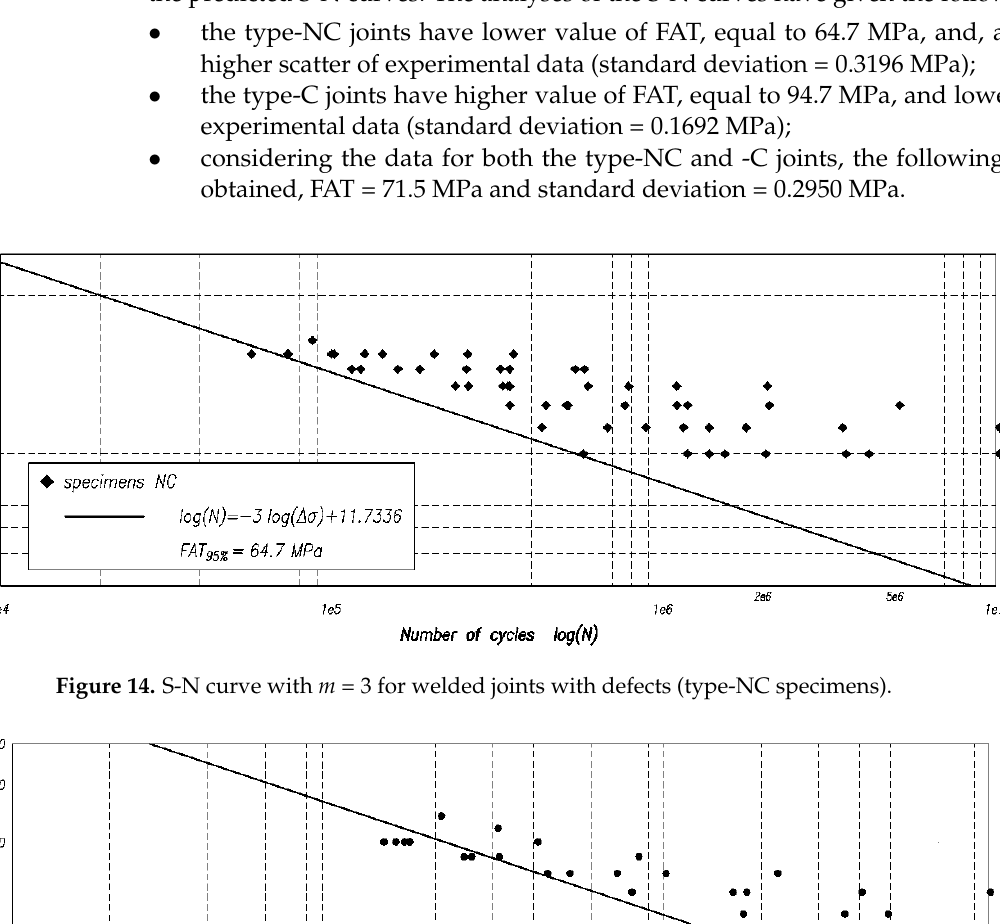
Figure 16. S-N curve with m = 3 for welded joints with and without defects (type-C and -NC specimens, respectively). 4.4. Defects Influence on Fatigue Strength The cumulative defects volume and the maximum defect size, evaluated by CT analyses for some specimens (Table 4), were normalized with respect to the thickness of the welded joints. The worsening effect of defect volume on the fatigue strength of the investigated welded joints was evaluated correlating the defect parameters (normalized